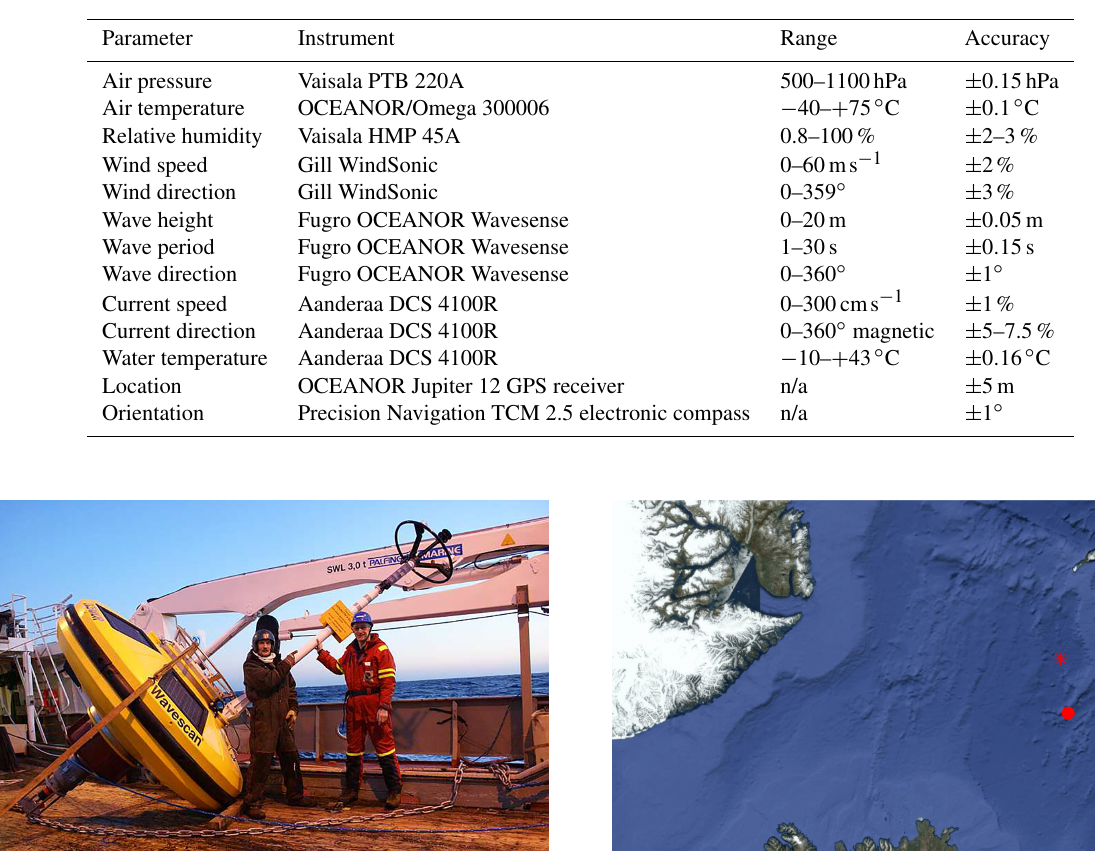
Table 1. The instrumentation of the buoy: parameters measured, instrument, range and accuracy according to manufacturers.